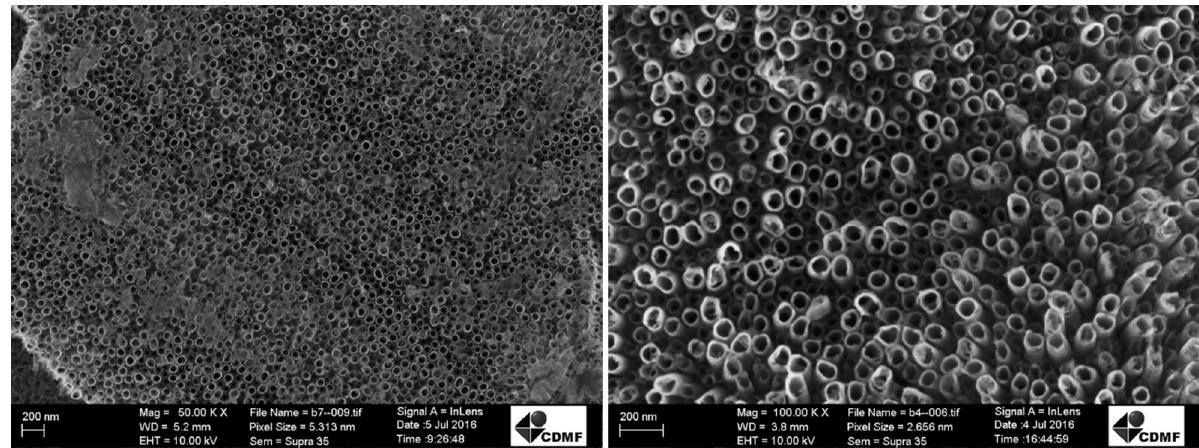
Figure 1. FESEM surface images with different magnifications of annealed TiO 2 -NT prepared via anodization of Ti foil at 25 V for 90 min in EG electrolyte containing 10% wt. H 2 O and 0.75% wt. NH 4 F.